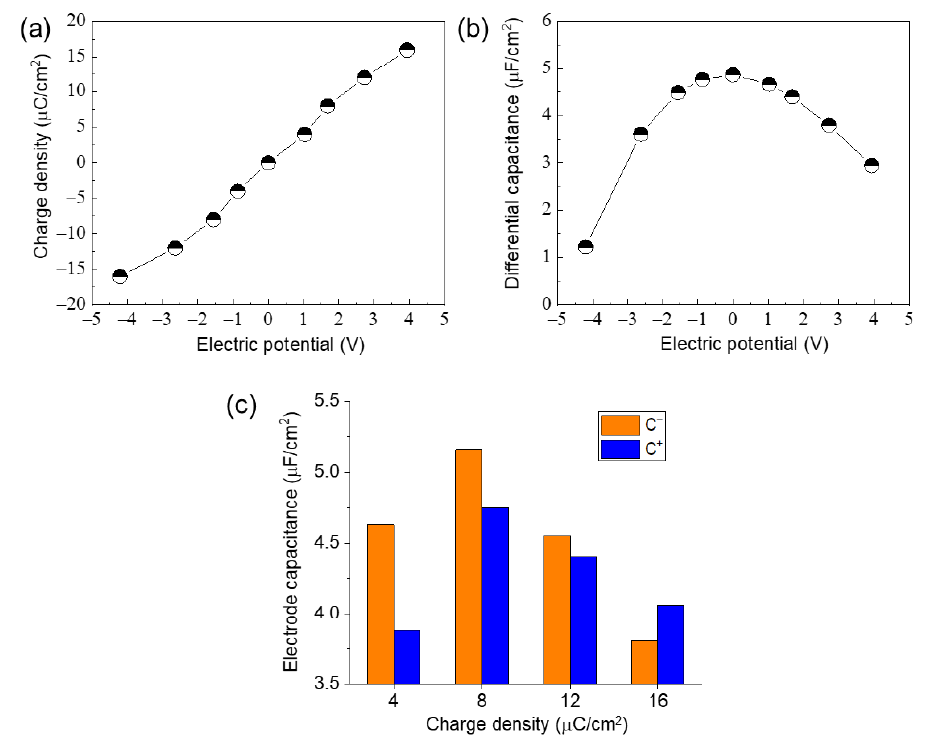
Figure 7. ( a ) Charge density as a function of electric potential. ( b ) Differential capacitance curves. ( c ) Electrode capacitance as a function of charge density.